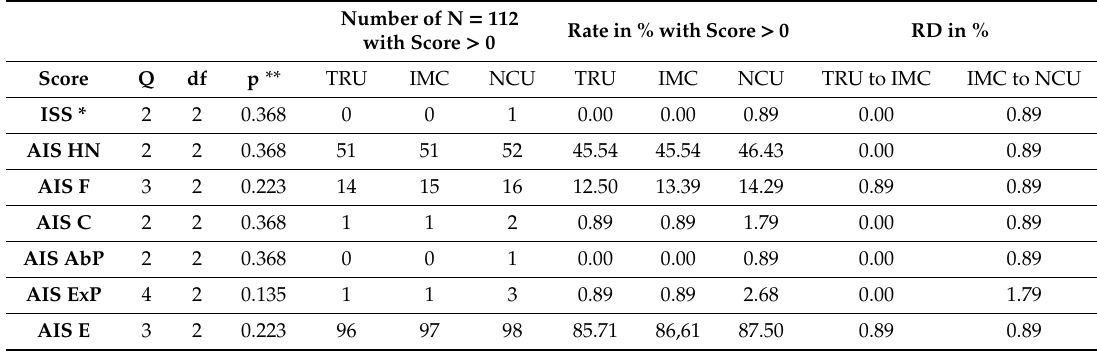
Table 7. Comparison of patients’ frequencies with AIS and ISS ≥ 1 throughout